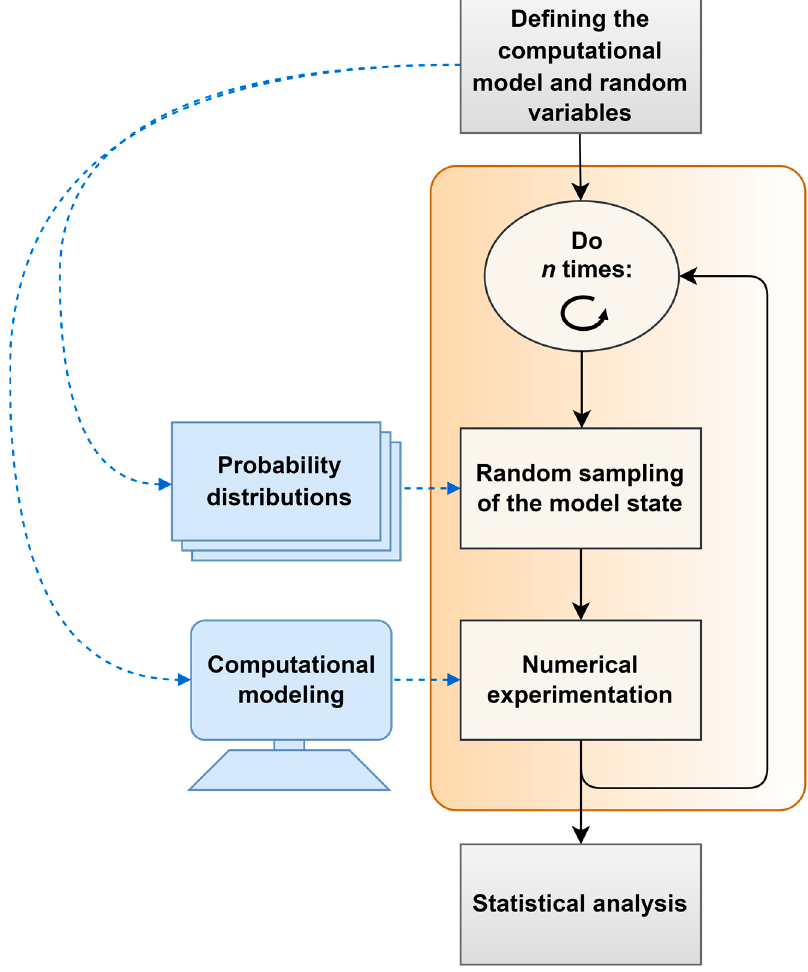
Figure 1. MCM flowchart.